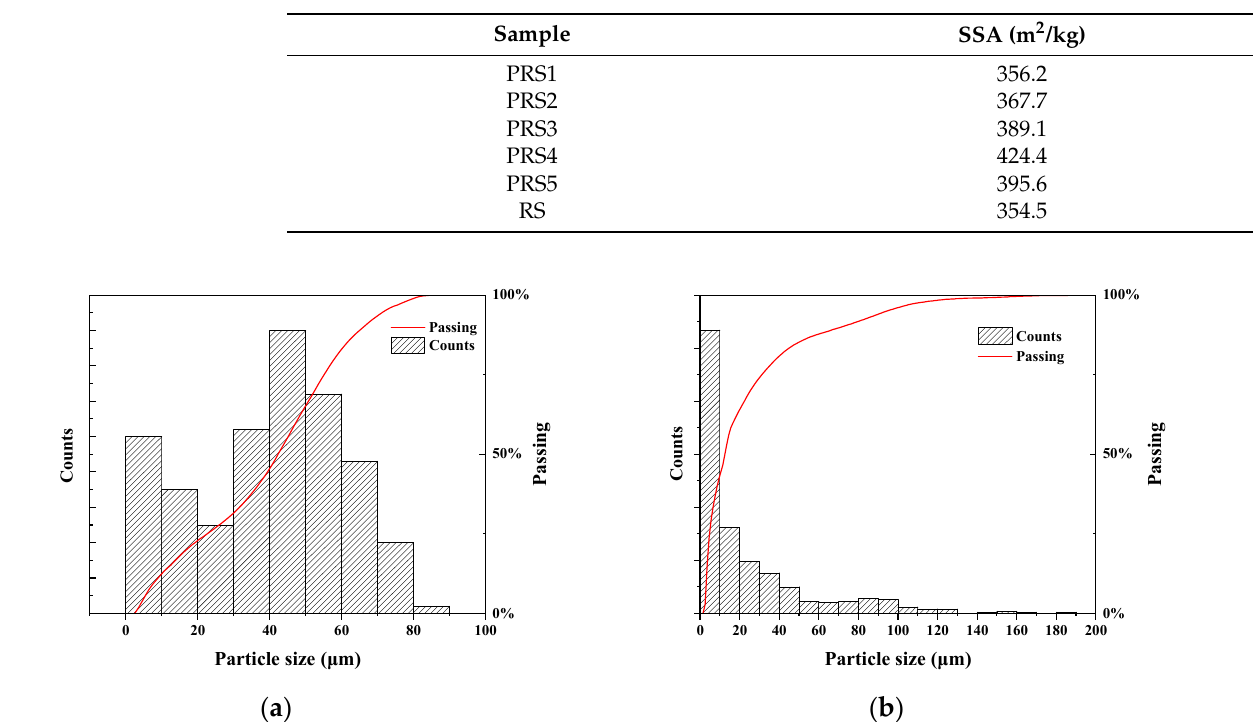
Figure 6. Particle distribution changes of SiC foaming. ( a ) Unfoamed reconstructed BOF slag; ( b ) Porous reconstructed BOF slag.